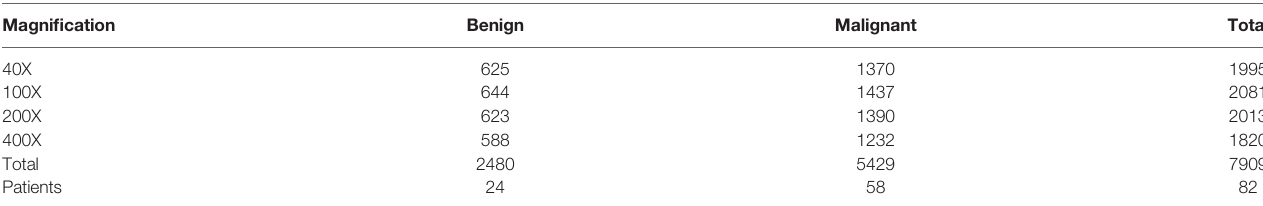
TABLE 1 | Image distribution by magni fi cation factor and class. Magni fi